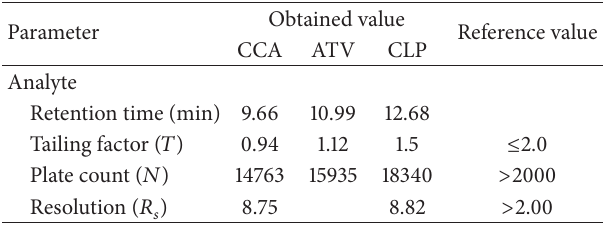
Table 5: System suitability test results for clopidogrel bisulfate, its carboxylic acid metabolite, and atorvastatin calcium by the proposed LC